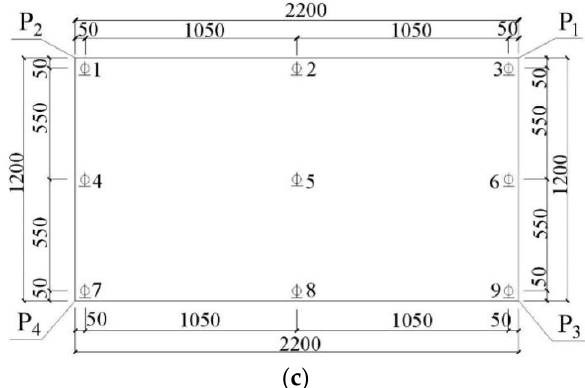
Figure 4. Arrangement of the testing points. ( a ) Strain rosettes on the upper surface; ( b ) Strain rosettes on the lower surface; ( c ) Displacement testing points.